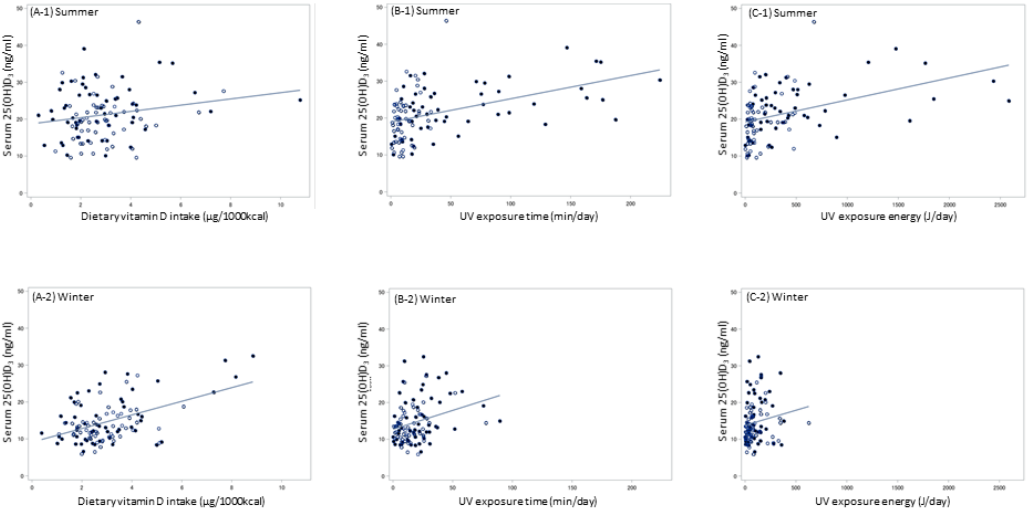
Figure 3. Relationship of serum 25(OH)D 3 with dietary vitamin D intake and UV exposure; ( A ) dietary vitamin D intake ( µ g / 1000 kcal) and serum 25(OH)D 3 concentration (ng / mL); ( B ) UV exposure time (min / day) and serum 25(OH)D 3 concentration (ng / mL); ( C ) UV exposure energy (J / day) and